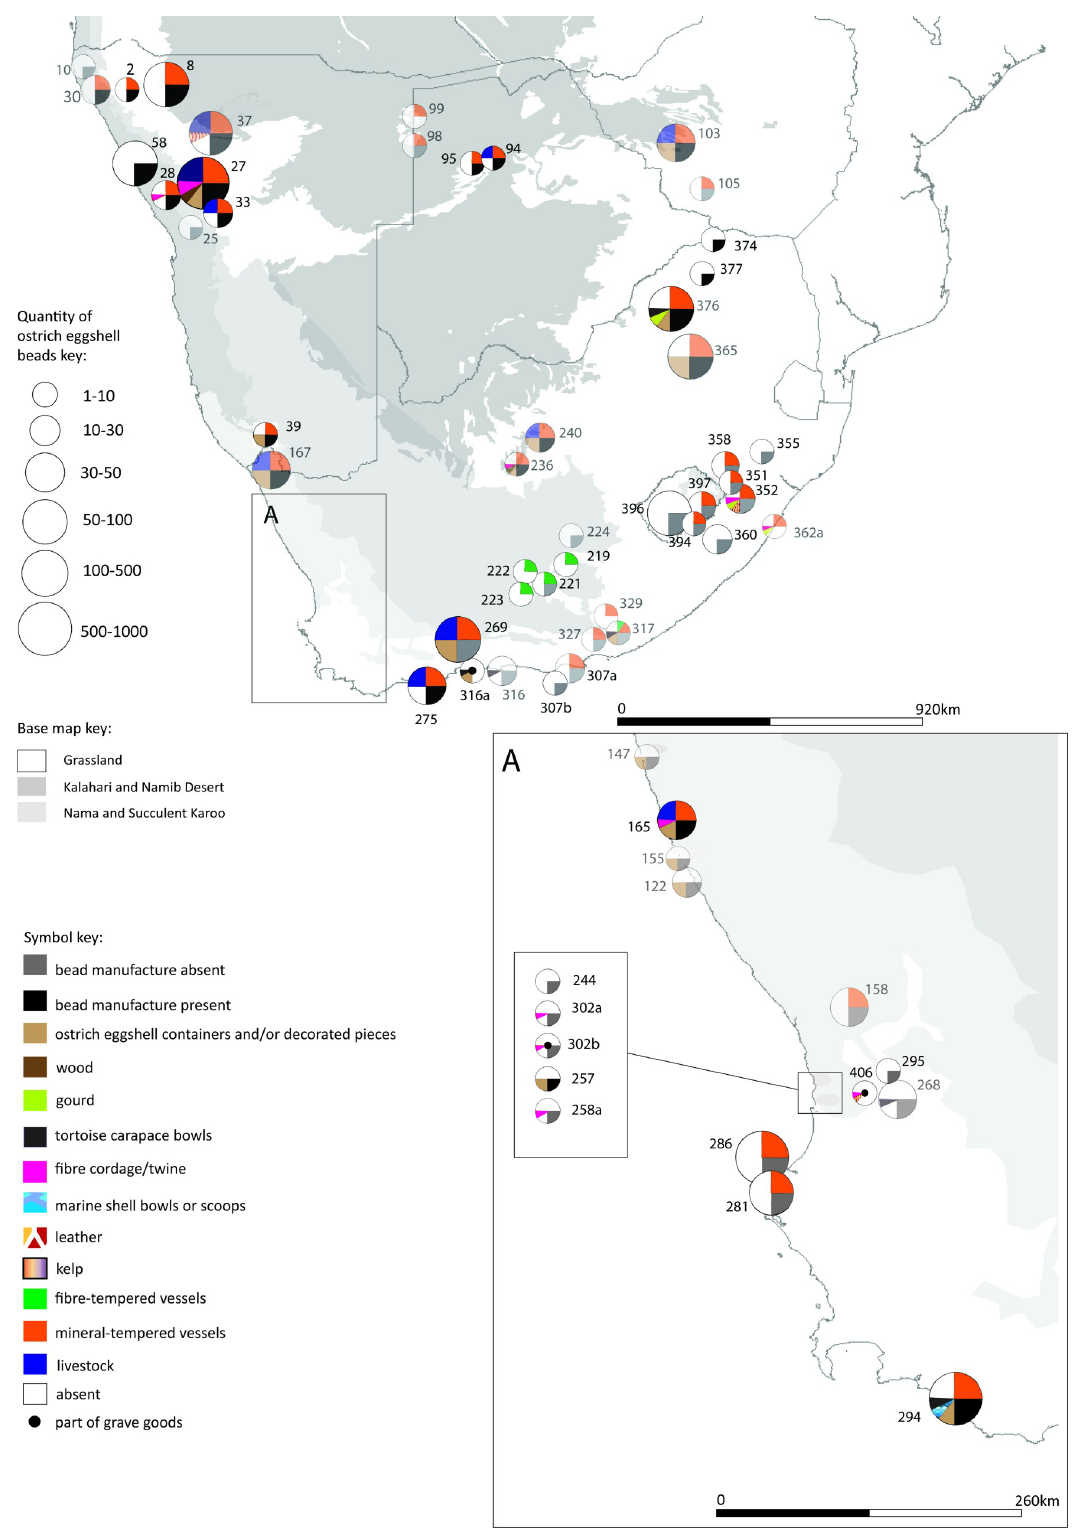
Fig 6. Map 2 showing the distribution of organic finds, livestock and pottery in the period 290 cal BC- cal AD 310.